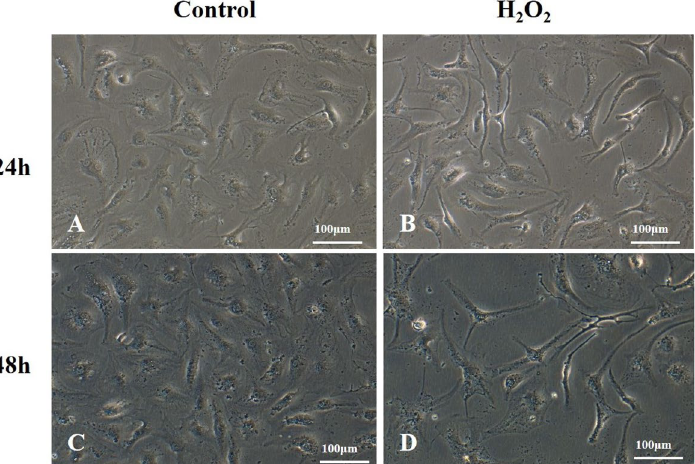
Figure 2. Morphology of MECs under the microscopy. MECs culture images of controls after the incubation for 24 h ( A ) and 48 h ( C ); MECs treated with H 2 O 2 (150 µM) for 24 h ( B ) and 48 h ( D ). Scale bar: 100 μm. MECs, meningothelial